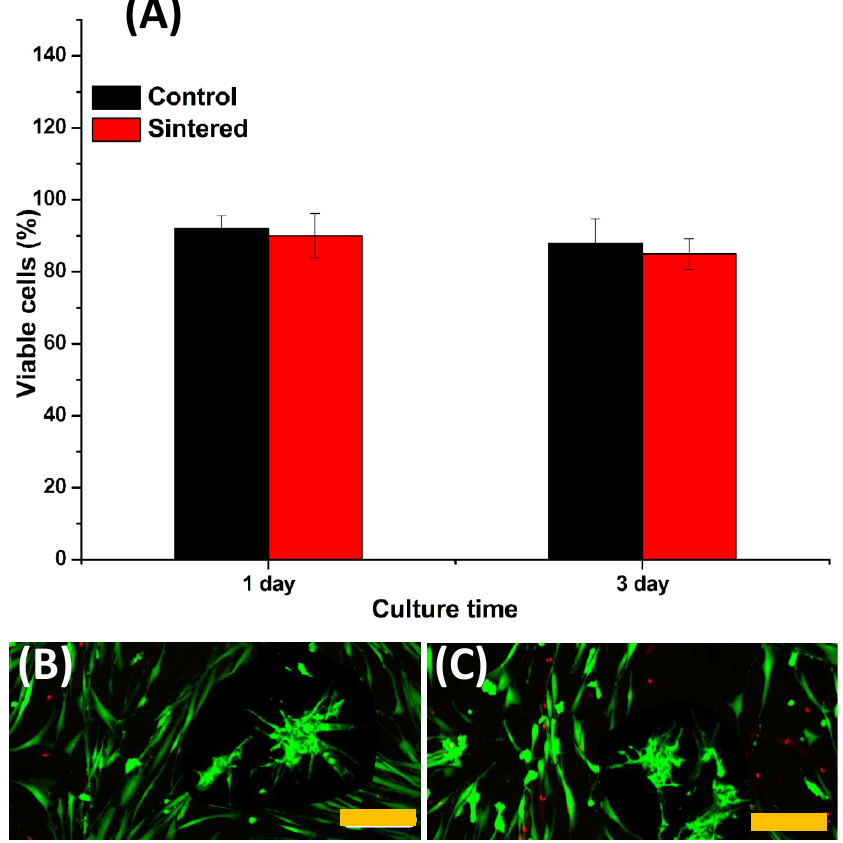
Figure 5. ( A ) Live /dead viability assay; ( B , C ) laser confocal images of MC3T3 osteoblast-like cells after 3 days of culture. Cytotoxic events that affect cell membrane integrity can be accurately assessed using this method. The live and dead cells exhibited green and red fluorescence, respectively. Dead